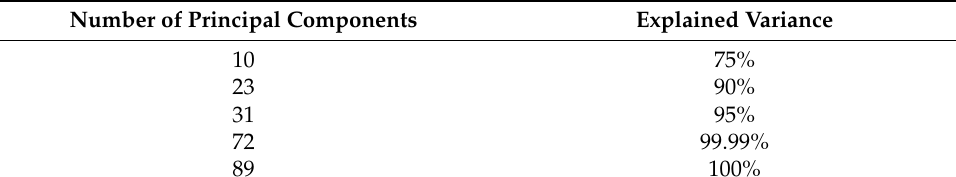
Table 3. Variance of original data captured by different number of principal components.